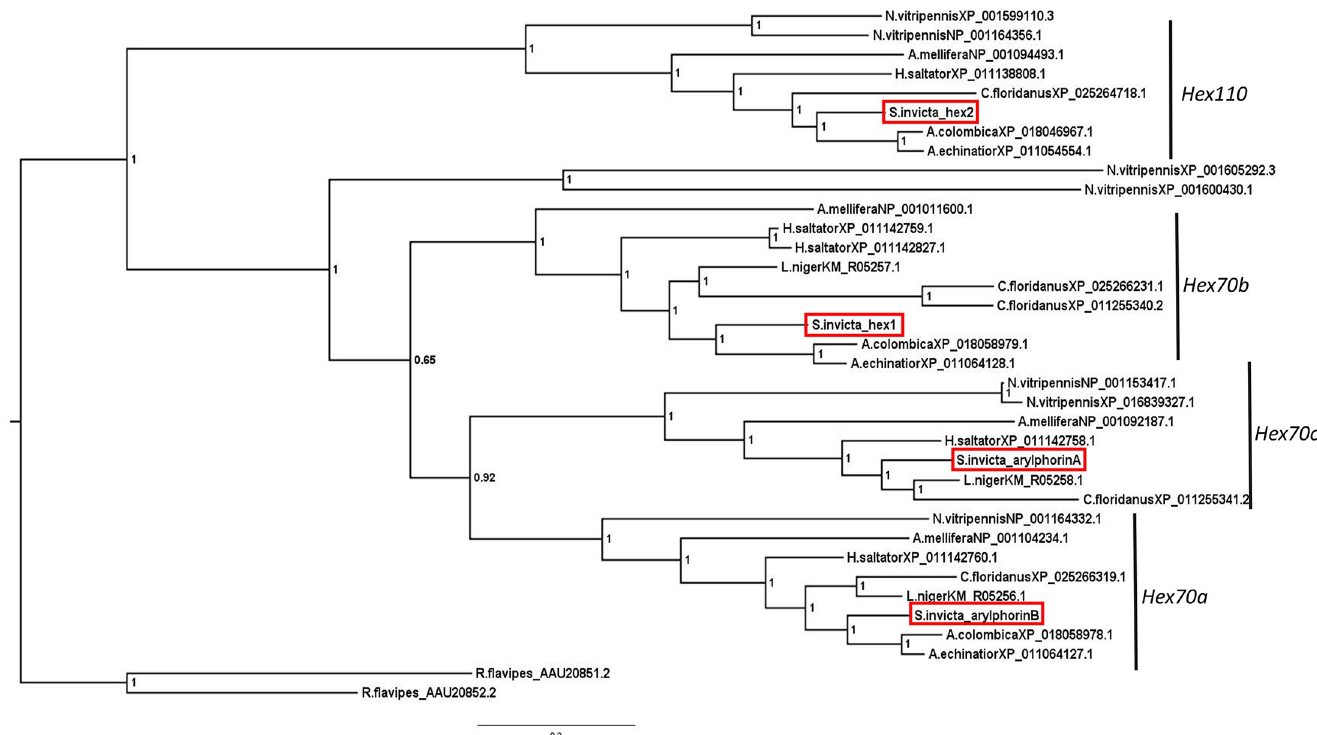
Fig 1. Phylogenetic analysis of S . invicta and other hymenopteran hexamerin candidate proteins under Bayesian inference. Node value posterior probability was rounded to two significant figures. Scale bar indicates branch length. The two hexamerins of the termite R . flavipes were used as the outgroup. The four clade names represent the four A . mellifera hexamerin proteins. The hexamerins of S . invicta (boxed in red) clustered as follows: Hexamerin 1 (XP_025995150.1) with Hex 70b, Hexamerin 2 (XP_011171862.1) with Hex 110, Arylphorin subunit alpha-like (XP_011155485.1) with Hex 70c, and Arylphorin subunit beta (XP_011155484.1) with Hex 70a. Alignment of the S . invicta hexamerin proteins can be found in supplementary information (S2 Fig).